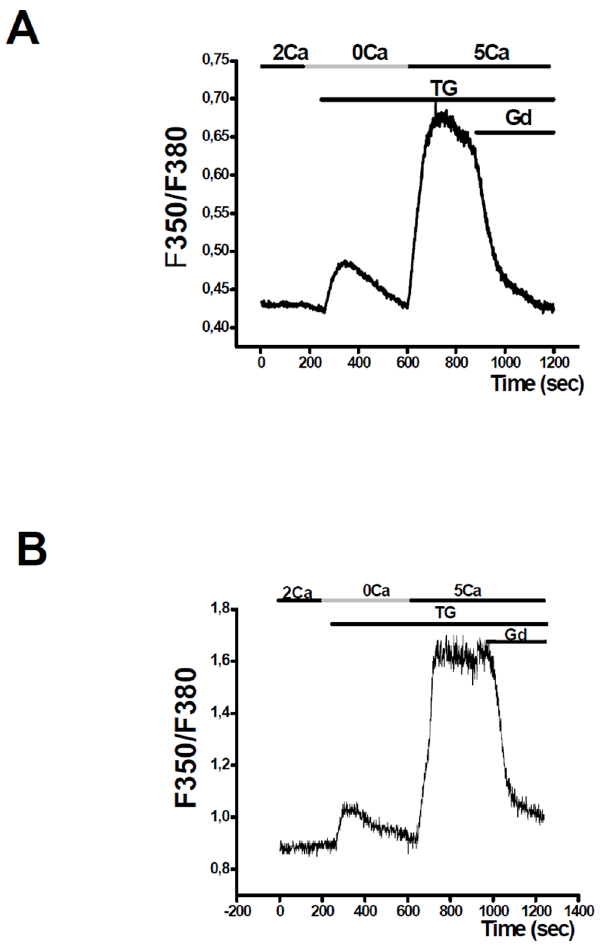
Figure 2. NSCLC cells display SOCE. Thapsigargin (TG, 1 m M) applied to NCI-H23 cells (A) or NCI-H460 (B) in 0 mM Ca 2 + solution (0Ca) induced an increase of F350/F380 fluorescence. Re-introduction of 5 mM Ca 2 + solution (5Ca) induced stable increase in Ca 2 + signal, a characteristic of SOCE. Gd 3 + applied in 5Ca solution induced inhibition of this Ca 2 + signal. ( p , 0.001, n=25 for NCI-H23 and n=28 for NCI- H460, Mann-Withney test).